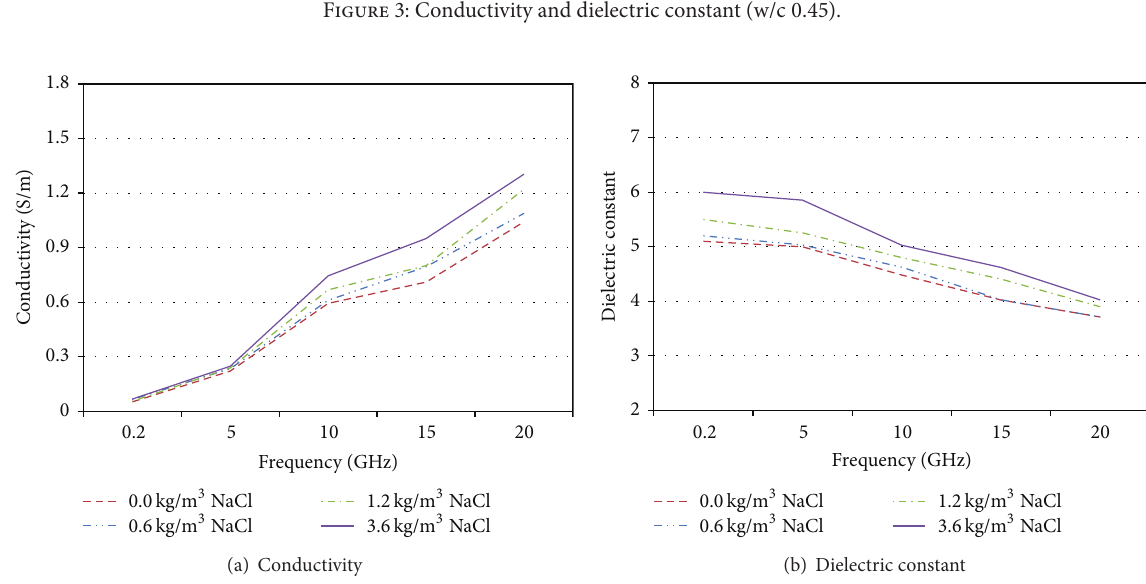
Figure 3: Conductivity and dielectric constant (w/c 0.45).